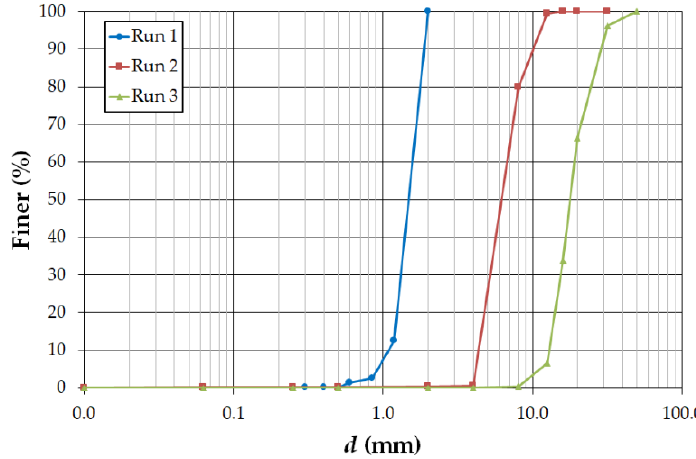
Figure 1. Grain-size distribution curve of the bed sediments for each experimental run.